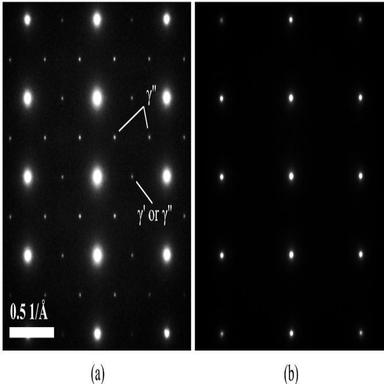
Electron diffraction patterns along the zone axis from (a) unirradiated and (b) dual ion irradiated (400 C, 150 dpa, ~13 appm He/dpa) alloy 725. Patterns were taken from the same grain (separated by ~2 mm) and show the loss of g0 and g00 superlattice reflections due to dissolution or chemical disordering of those phases.